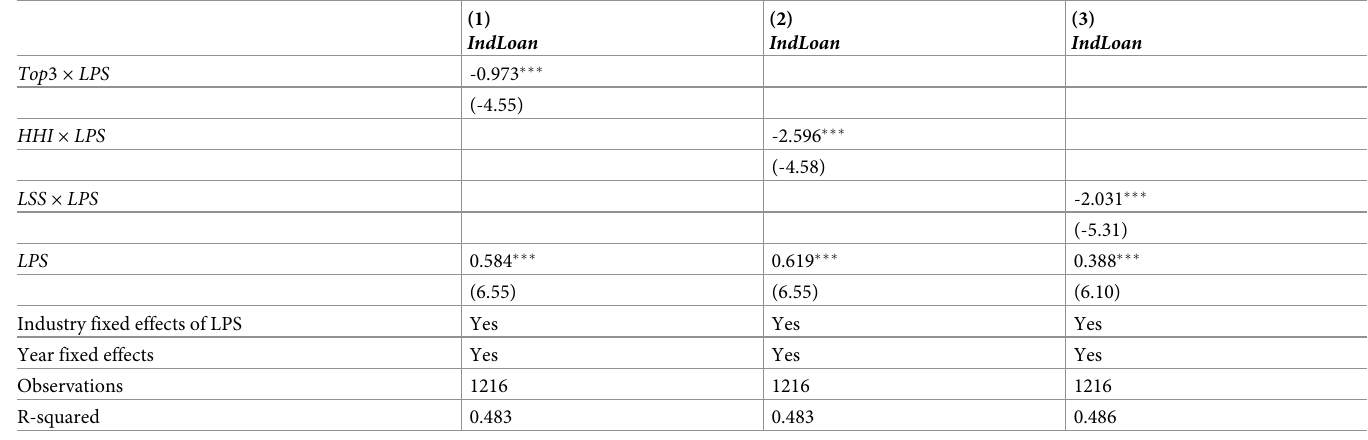
Table 11. The role of ownership structure. This table reports the estimation results from OLS regressions analyzing the impact of the largest private shareholder on bank lending to their industry taking into account the role of ownership structure. Columns 1–3 uses IndLoan as the dependent variable. Variables are defined in S1 Appendix. The sample period is from 2007 to 2020. In parentheses are t-statistics. ��� , �� , � indicate statistical significance at the 1%, 5%, and 10% level,